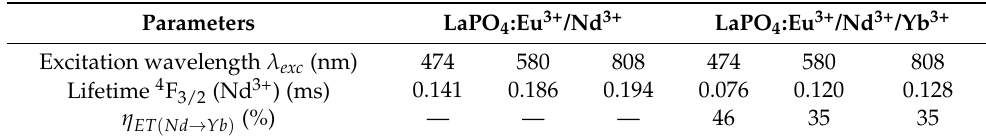
Table 2. The spectroscopic parameters of LaPO 4 :Eu 3+ /Nd 3+ and LaPO 4 :Eu 3+ /Nd 3+ /Yb 3+ samples under different excitation